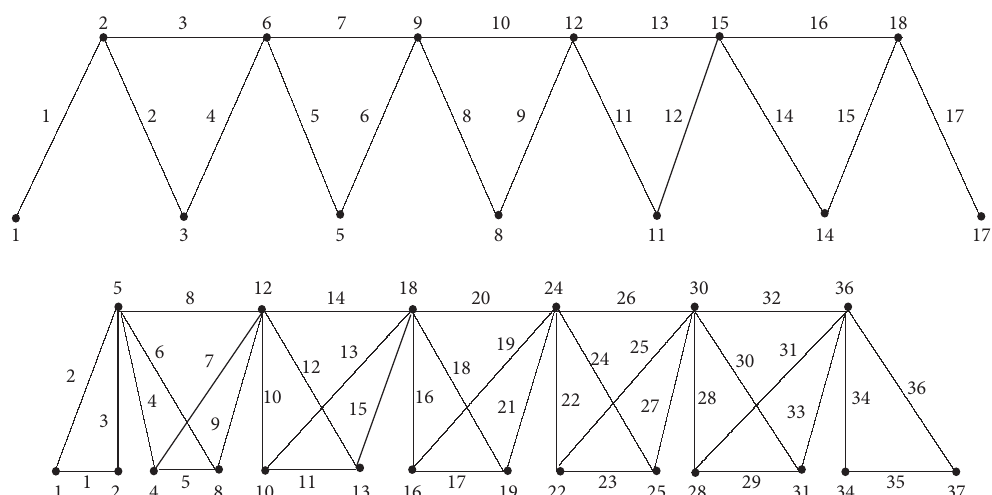
Figure 4: A classical mean labeling of L ( P